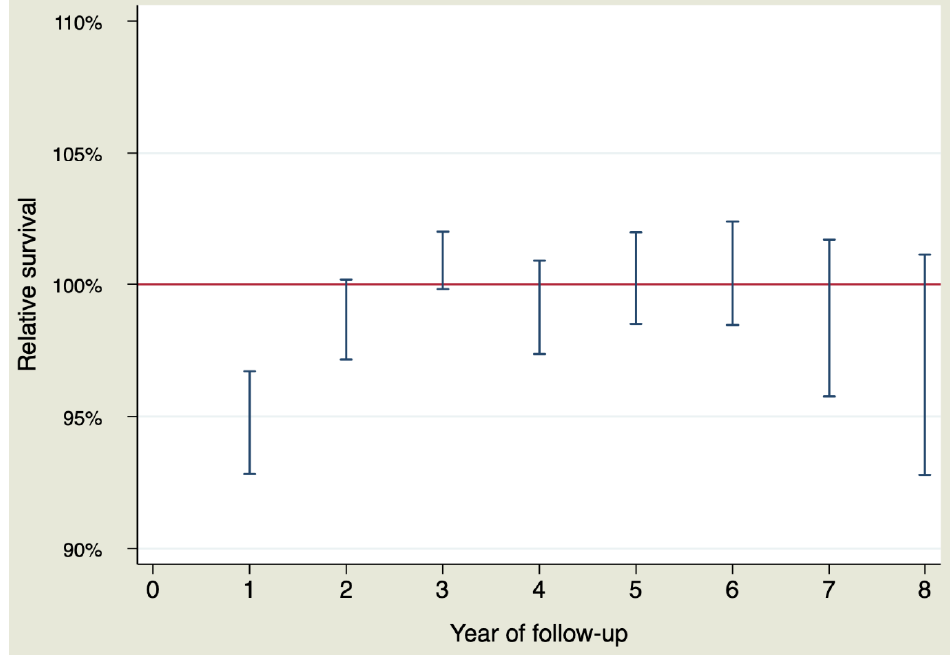
Figure 2. Relative survival for each year of follow-up.